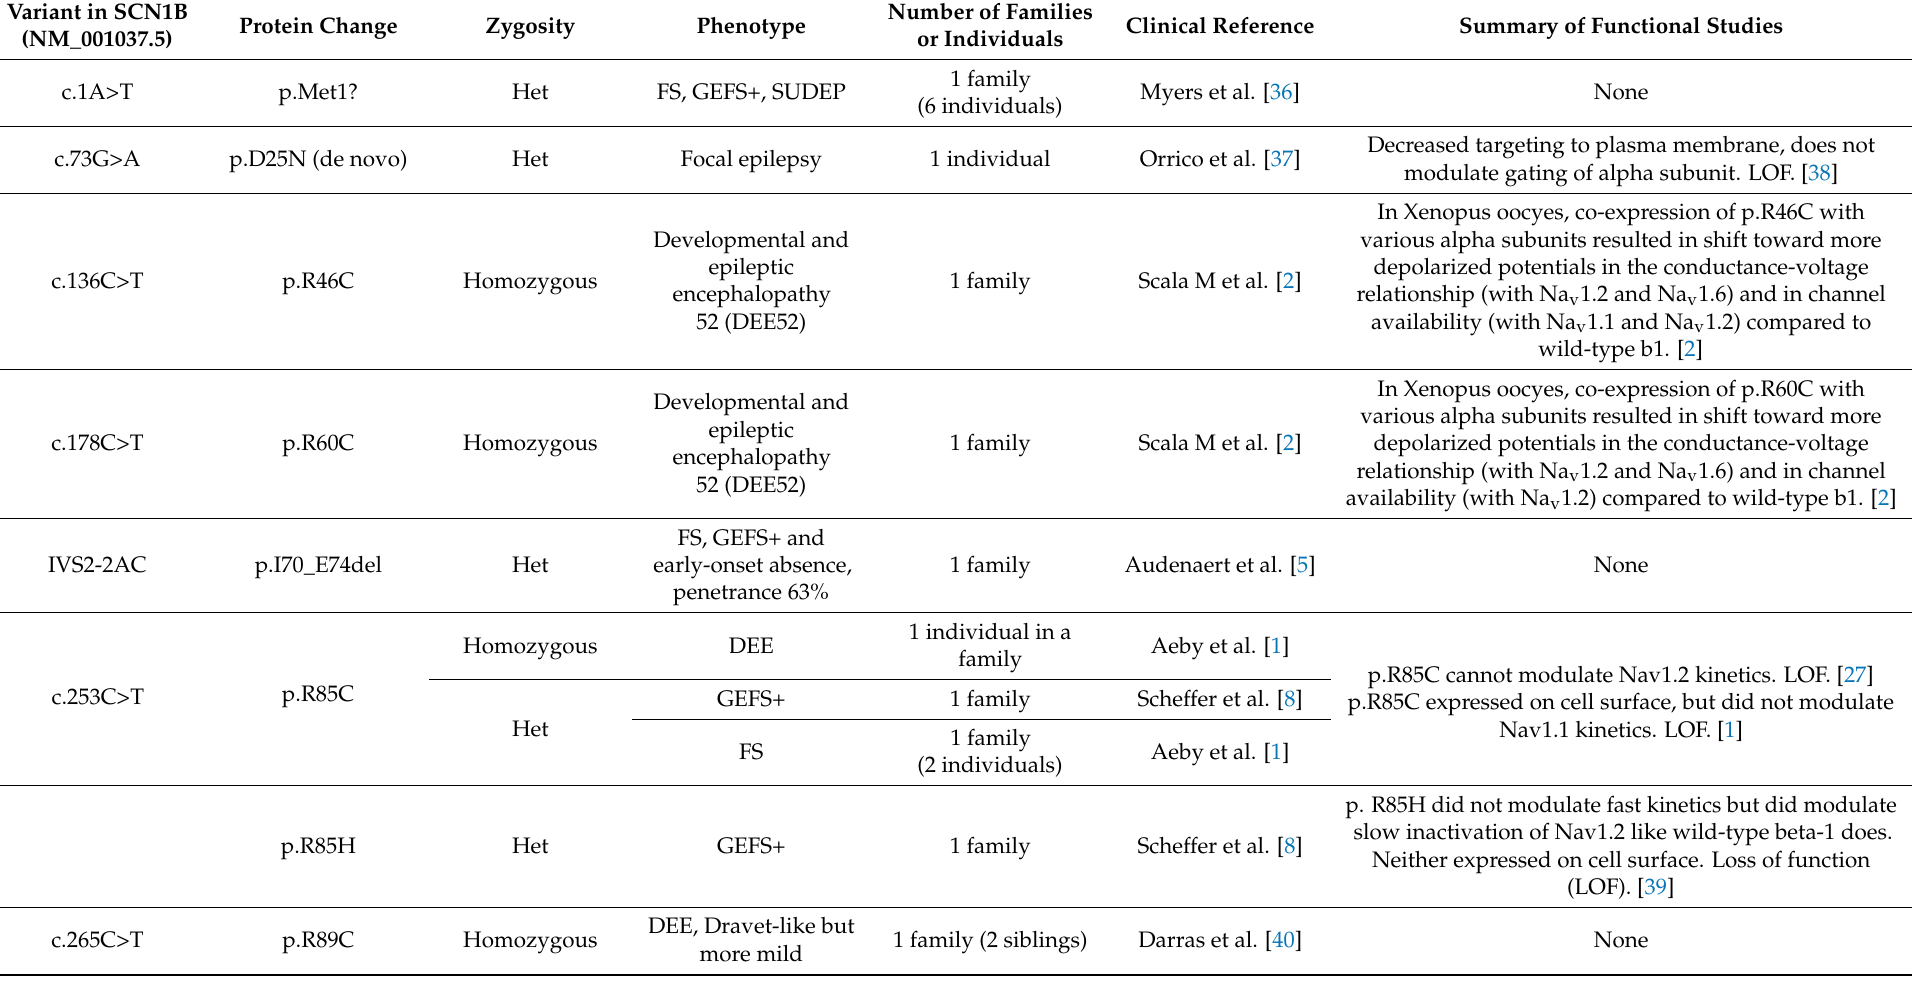
Table 2. Summary of SCN1B variants causing epilepsy and neurodevelopmental delay, with functional studies on specific